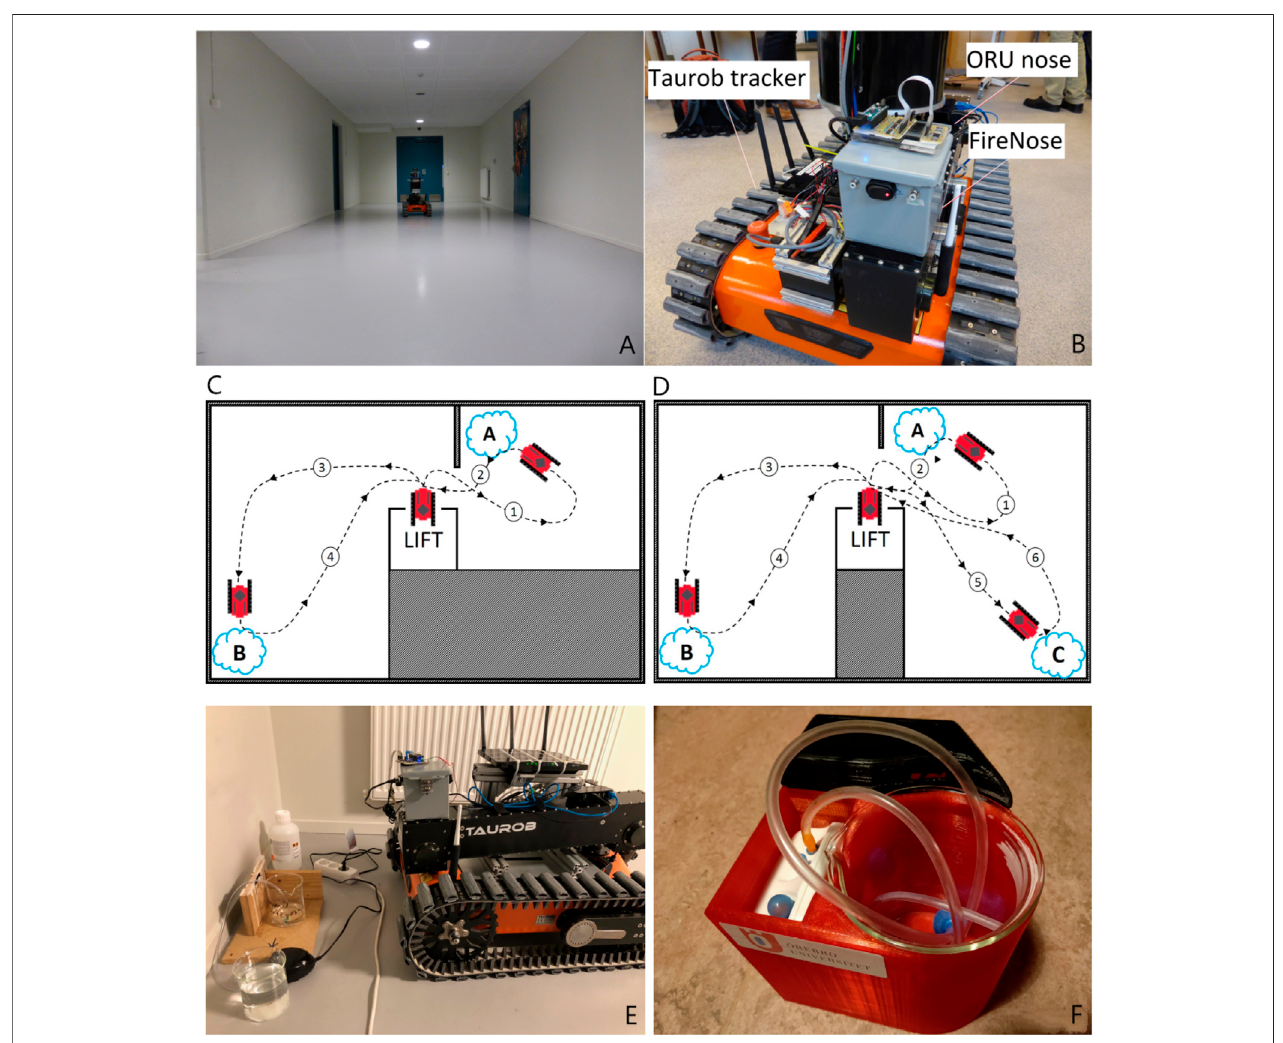
FIGURE 6 | The experimental setup. (A) The basement environment of the fi eld experiment reported in this paper. (B) A Taurob tracker is used as the platform to carry the gas sensing payload, namely the FireNose and ORU nose. (C) and (D) Schematic drawings of the 2-source trials and the 3-source trial, respectively. (E) A simple gas source set-up used in the early trials of the experiment. (F) Standardized gas source used in later trials, which that consists of a fan and an air pump bubbler covered by a 3D printed case.